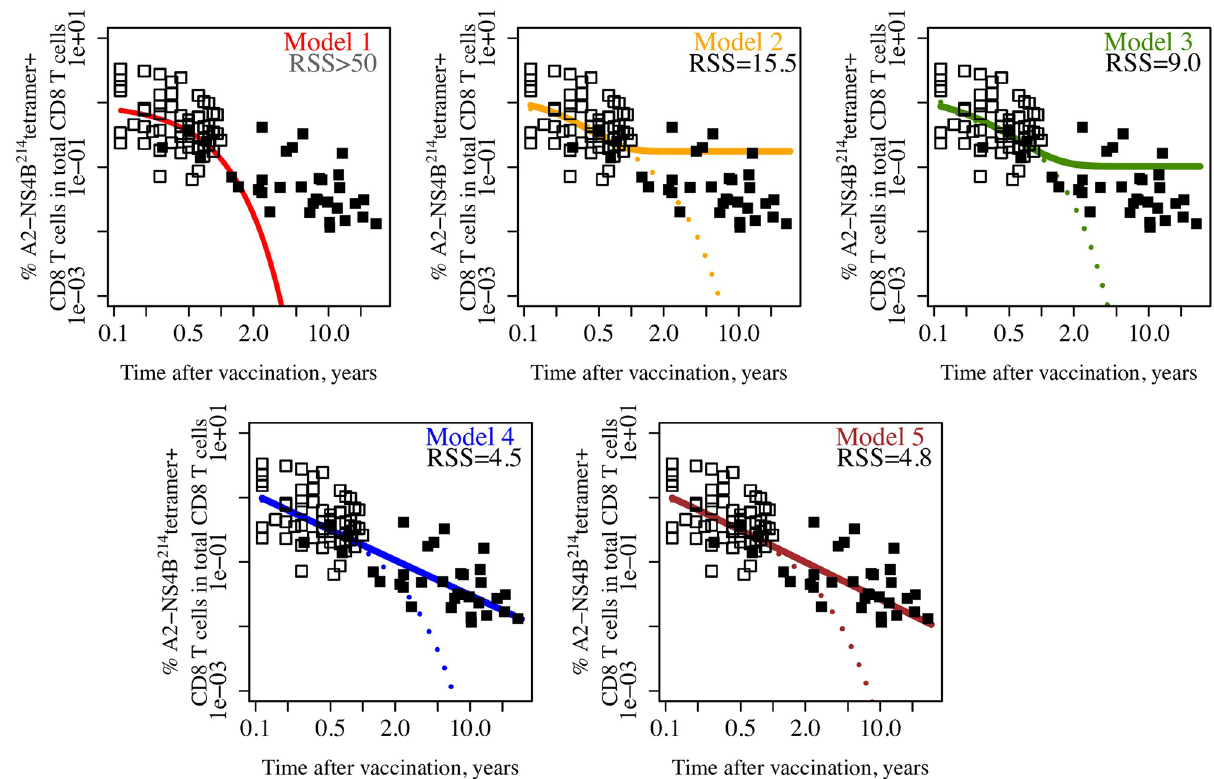
Fig 4. Integrated analysis of the data suggests that Models 4 and 5 predict the data in the Marraco study better than the other models. Data from the Akondy study [24] and the Marraco study [14] are shown as open and closed squares, respectively. For each model, we use fit to the Akondy data to predict the % of YFV-specific cells in total CD8 T cells up to 30 years after vaccination and compare this prediction with the Marraco data using residual sums of squares (RSSs). Dotted lines in panels with Model 2–5 show predictions from the corresponding models with unrestricted parameters. RSSs for these models are more than 50 (not shown) indicating a poor fit. As YFV-specific cells in the Akondy study were measured as % of lymphocytes and in the Marraco study as % of CD8 T cells, we converted the cell number predictions from fitting the Akondy data using the following formula. Since 45–70% of PBMCs are T cells and about 30% of them are CD8 T cells, we used a conversion factor equal to 0.575 � 0.3 � 0.17. Plotting how this result depends on the conversion factor (S5 Fig) shows that Models 4 and 5 consistently show a better fit. Models colors are as in Fig 2: